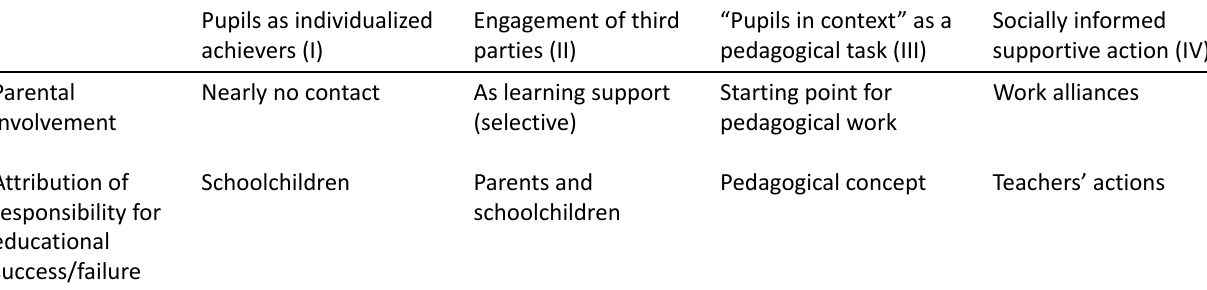
Table 1. Teachers’ orientation in addressing social